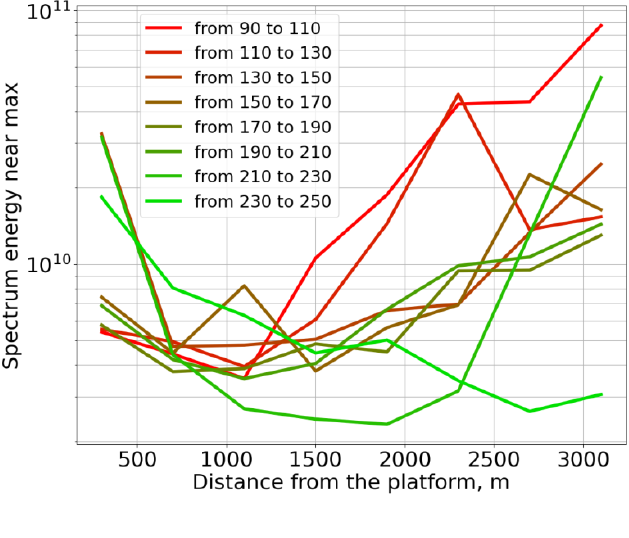
19 of 23 Figure 12. ( a,c ) Dependence of the exponent of power-law approximation for frequency range of 0.25–0.50 Hz on the distance to the platform in different directions in directional and polar repre- sentation; ( b , d ) Same for frequency ranges 0.8–1.2 Hz; In (b,d) colors characterizing the slope coef- ficients are superimposed on the location of the segments. To study the wave spectra depending on the direction, using the dispersion relation (21), a transition was made from the spectrum of elevations depending on the wave- number, to the spectrum of elevations depending on the frequency and direction of the waves: